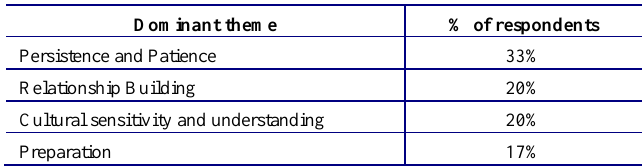
Table 8: Dominant themes contributing to successful